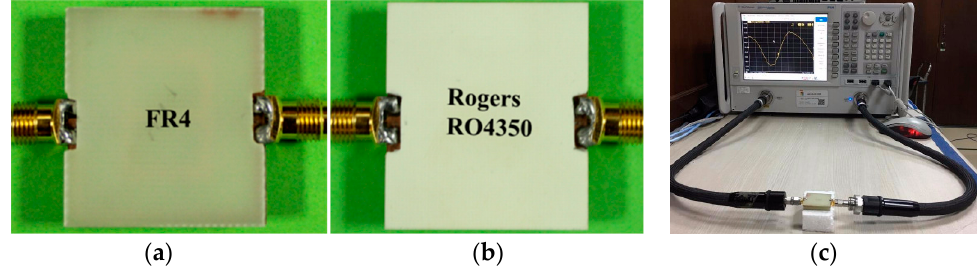
Figure 8. Sensors with over-layers: ( a ) FR4 over-layer, and ( b ) Rogers RO4350 over-layer. ( c ) PNA measurement set-up.